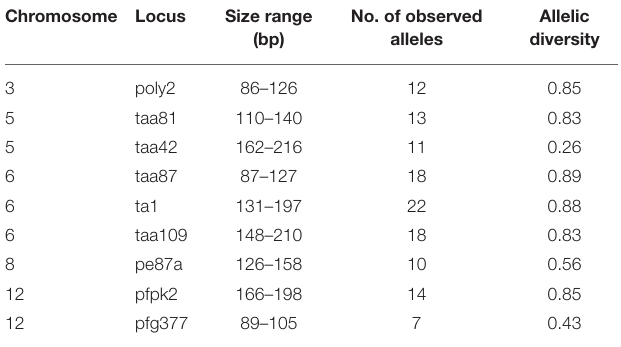
TABLE 3 | Pairwise F ST value (lower diagonal) and p -value (upper diagonal) of SNP and microsatellite datasets. North